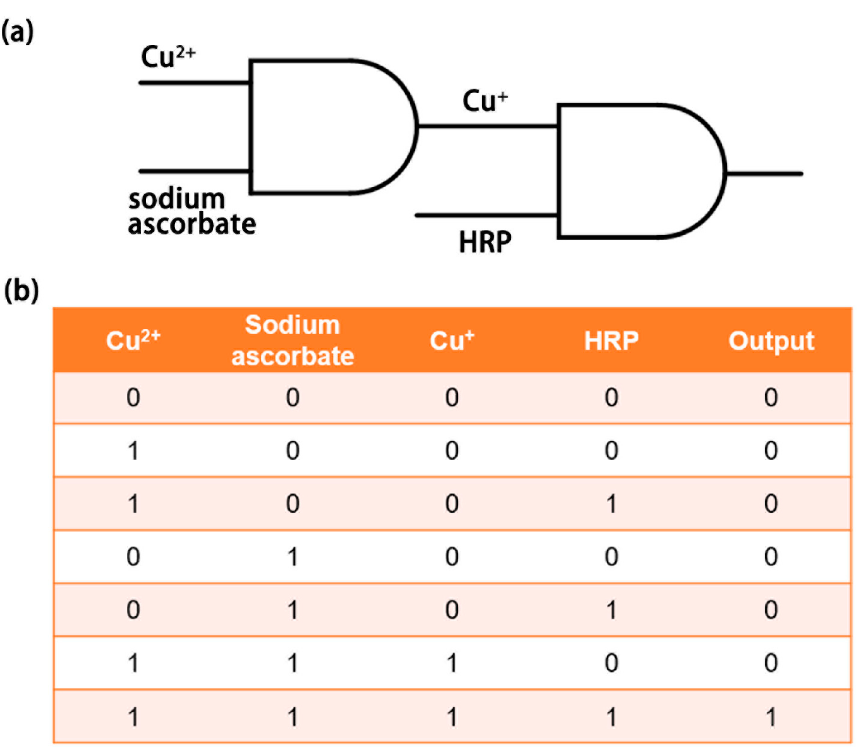
Figure 6. The logical structure of biological logic gates: ( a ) schematic of a biological logic gate. ( b ) Truth table for biological logic gates.